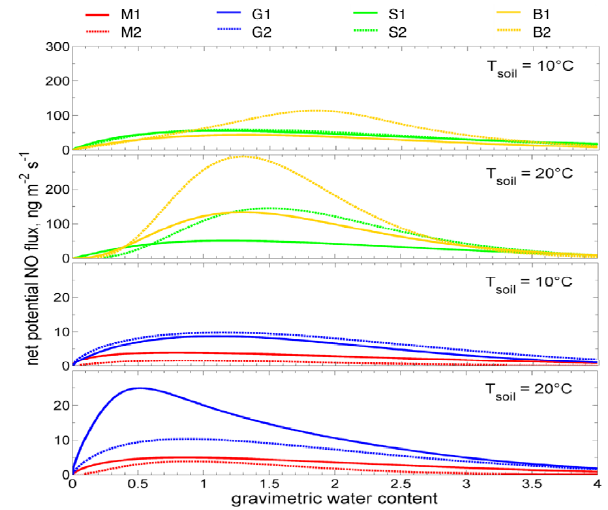
Fig. 8. Net potential NO flux (all expressed in terms of mass of from soil samples taken under moss, spruce and blueberry covered patches (note different nitrogen) at 10 ◦ C and 20 ◦ C from soil samples taken under moss, scales of the y-axes). spruce and blueberry covered patches (note different scales of the